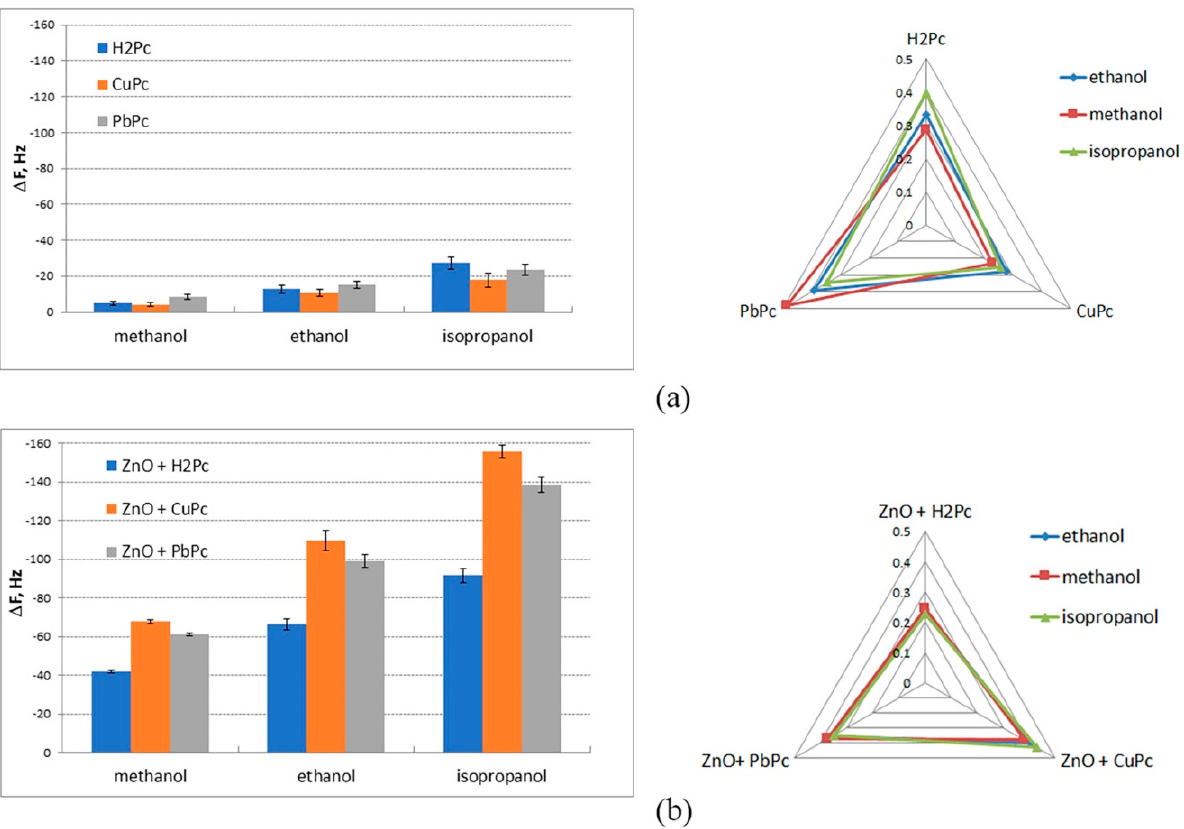
Figure 2. Response amplitudes ( left ) and chemical images ( right ) of methyl, ethyl, and isopropyl alcohols for QCM sensors arrays: ( a ) based on H 2 Pc, CuPc, and PbPc sensitive layers; ( b ) based on hybrid ZnO-H 2 Pc, ZnO-CuPc, and ZnO-PbPc layers.